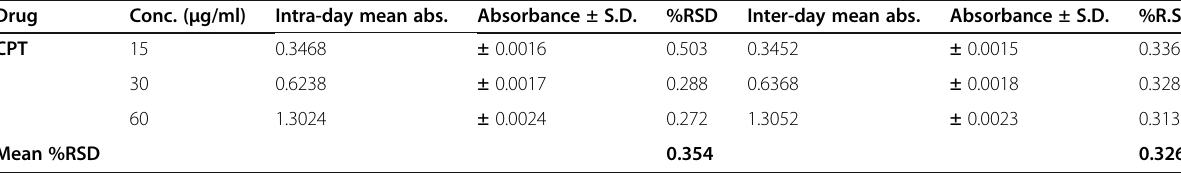
*Each value represents mean ± S.D. of three